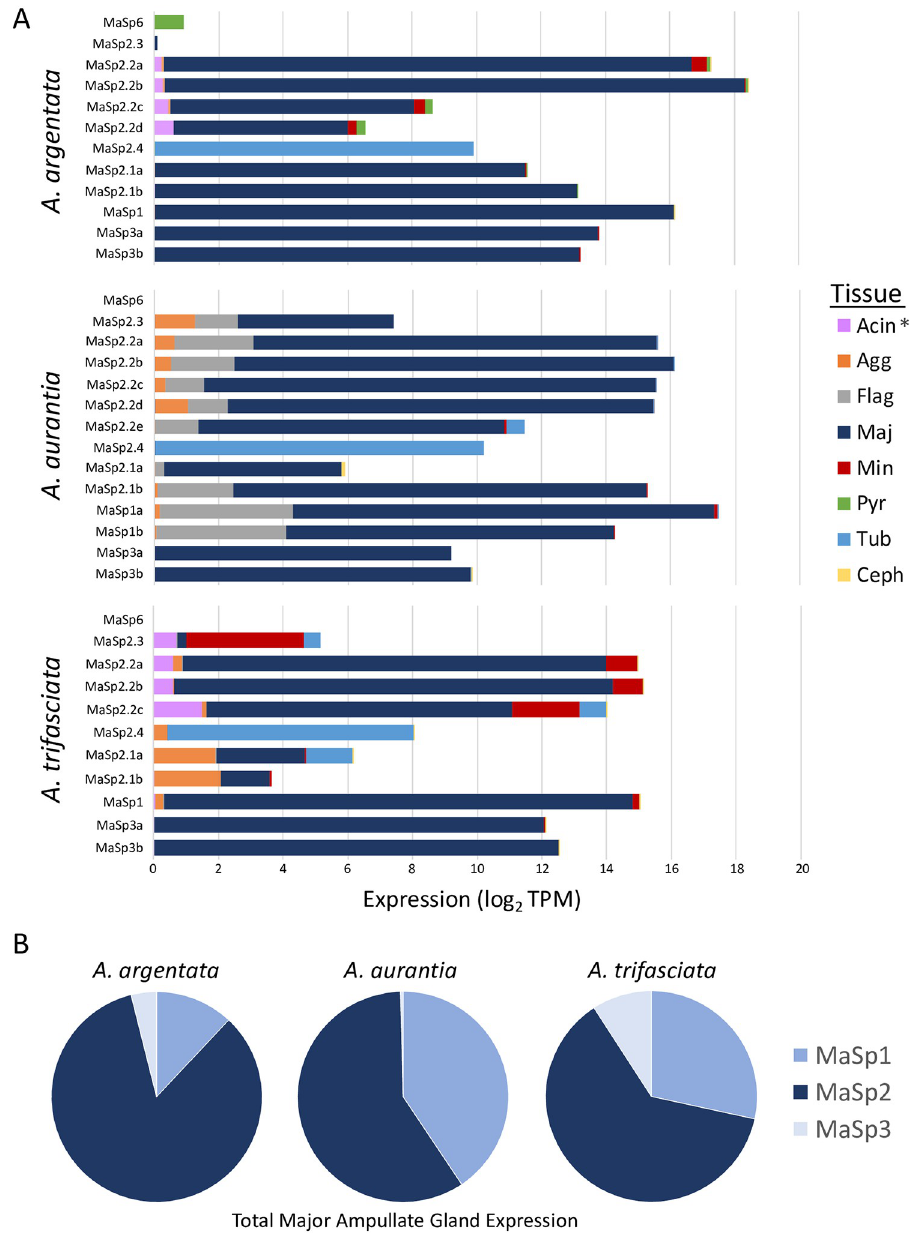
Fig 6. MaSp Gene Expression. A) Proportional gene expression in different tissues for each gene. Tissue abbreviations: Acin–aciniform gland, Agg–aggregate gland, Flag–flagelliform gland, Maj–major ampullate gland, Min–minor ampullate gland, Pyr–pyriform gland, Tub–tubuliform gland, Ceph–cephalothorax. Asterisk at Acin indicates that, for A . aurantia and A . trifasciata , this tissue is a combination of the aciniform and pyriform glands. B) Proportional gene expression summed across all paralogs of the three primary poly-A MaSp